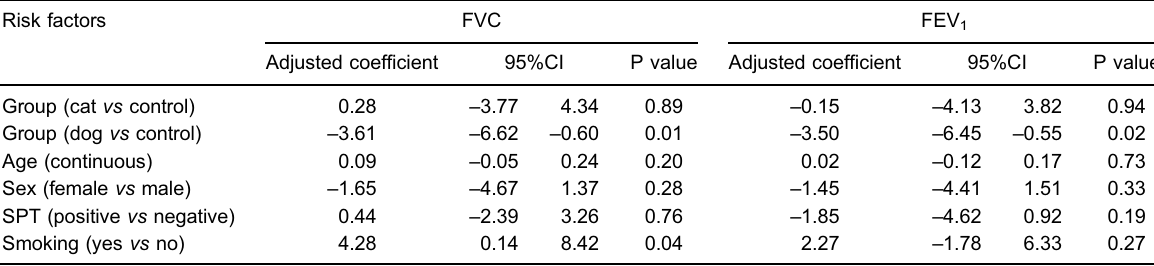
Table 3. Assessment of risk factors for reduction in FVC and FEV